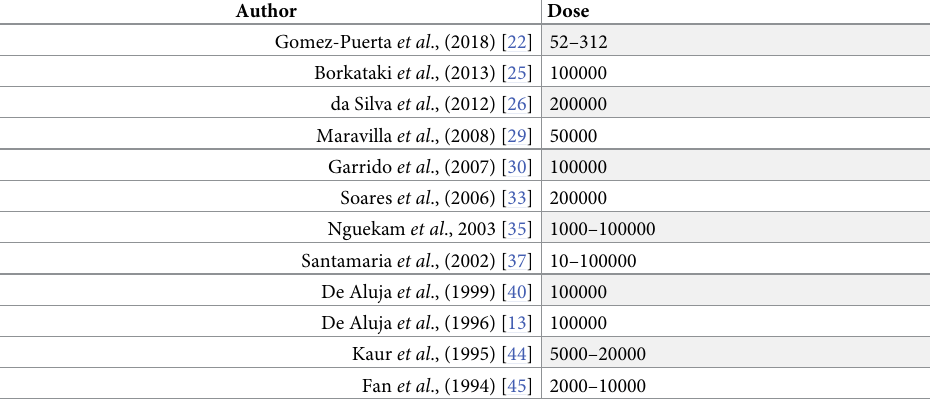
Table 4. Description of the Taenia eggs as infecting material and the dose using the oral route in the studies for T . solium .